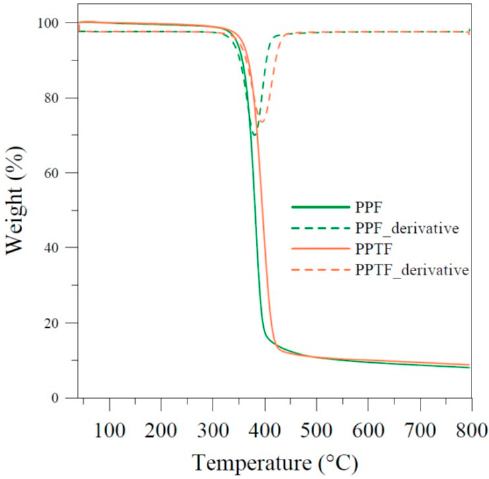
Figure 4. Thermogravimetric curve (solid line) and corresponding derivative (dashed line) under nitrogen flow for PPF and PPTF.